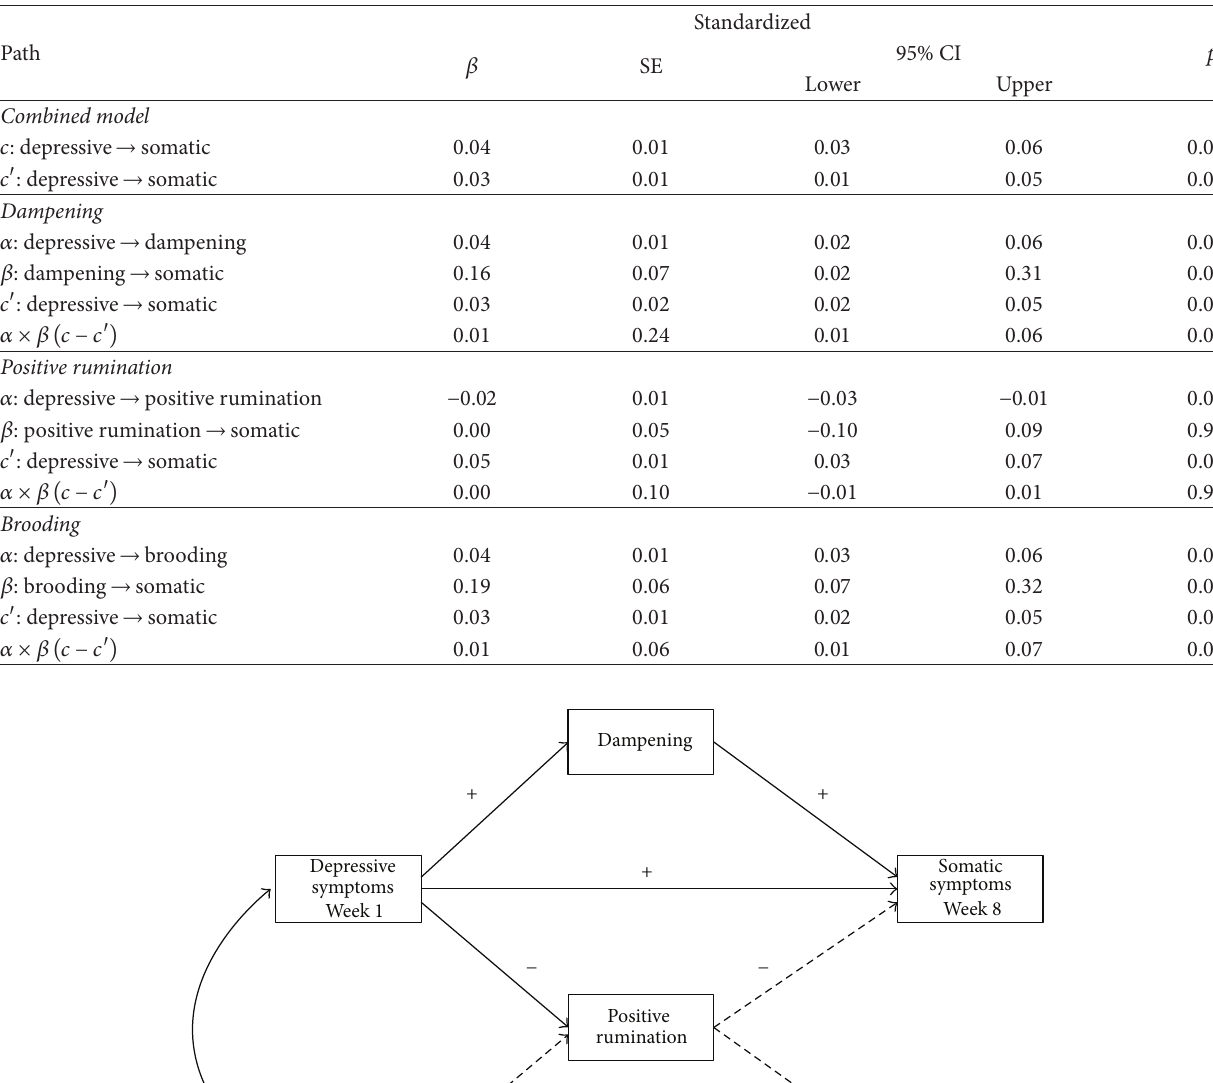
Table 3: Bootstrapping test of mediation effects predicting somatic symptoms.